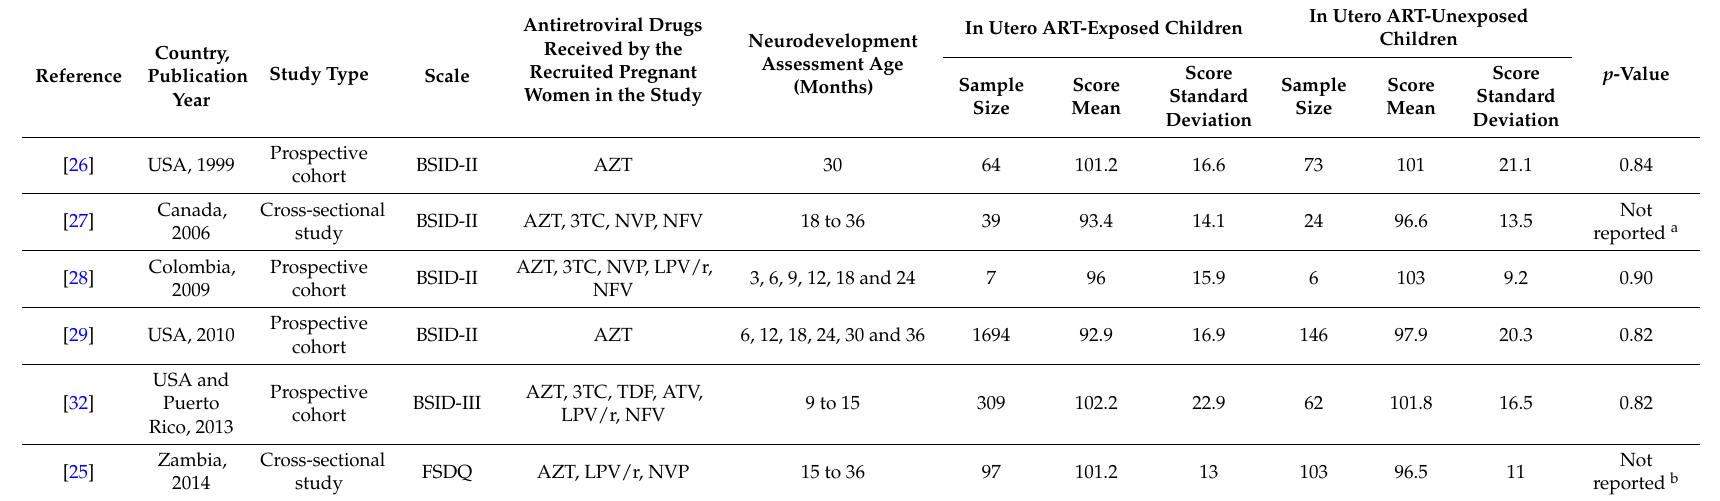
Table 1. Summary of the six studies characteristics that were included in the meta-analysis for the estimation of the effects of antiretroviral therapy (ART) exposure in utero on neurodevelopmental scores of children born to mothers living with human immunodeficiency virus type 1 (HIV-1).